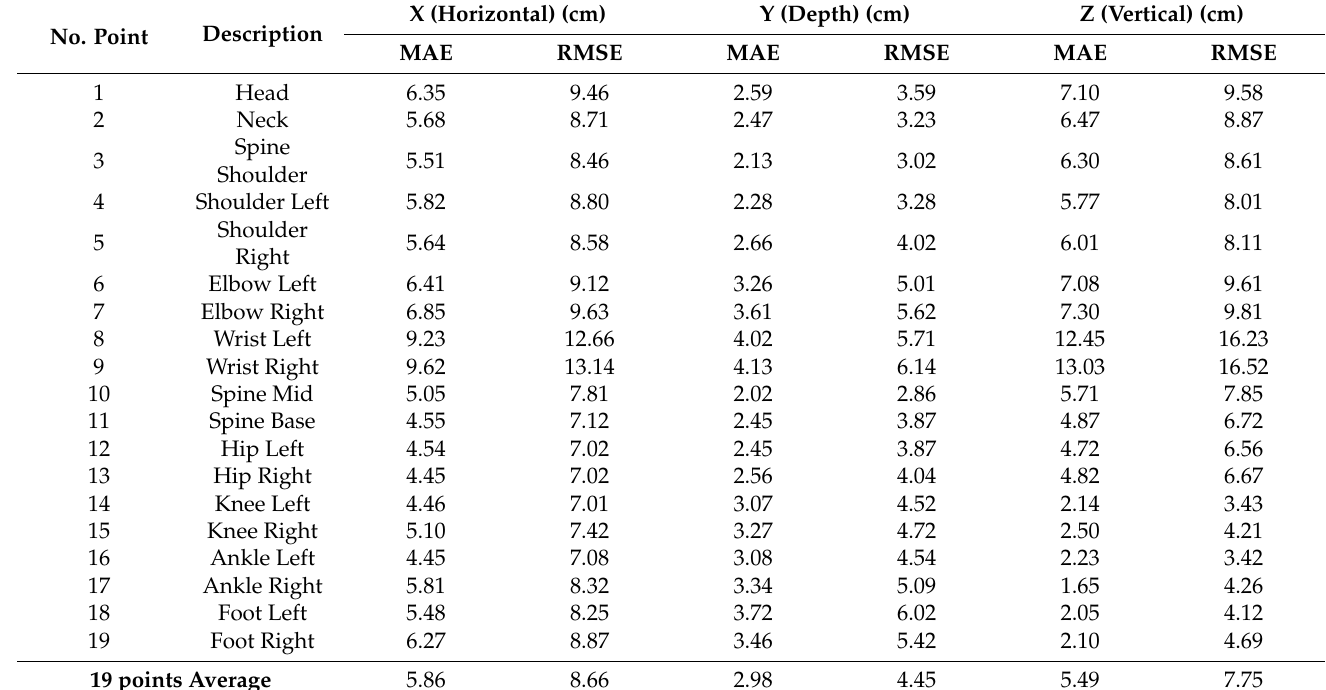
Table 3. Average Localization Error for 3D joint